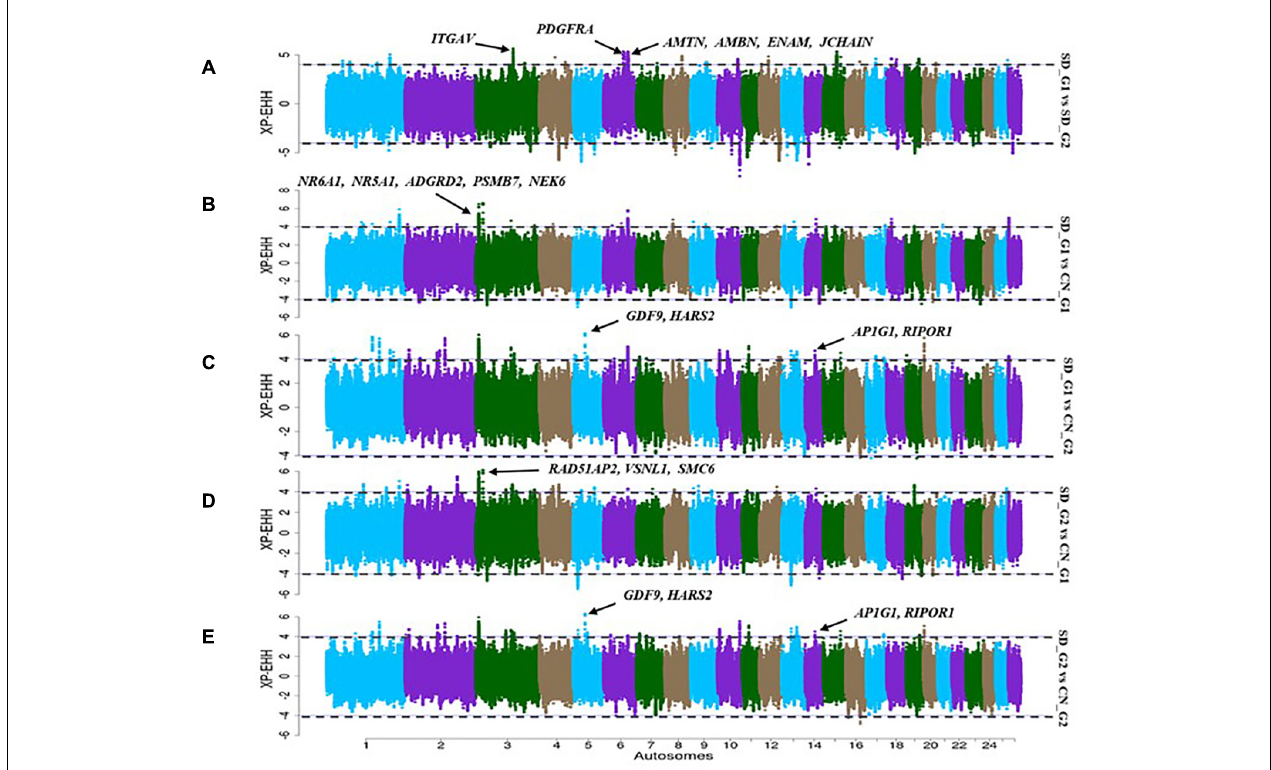
FIGURE 5 | Manhattan plots showing the candidate signatures of selection as determined with XP-EHH. (A) SD_G1 vs. SD_G2; (B) SD_G1 vs. CN_G1; (C) SD_G1 vs. CN_G2; (D) SD_G2 vs. CN_G1; (E) SD_G2 vs.